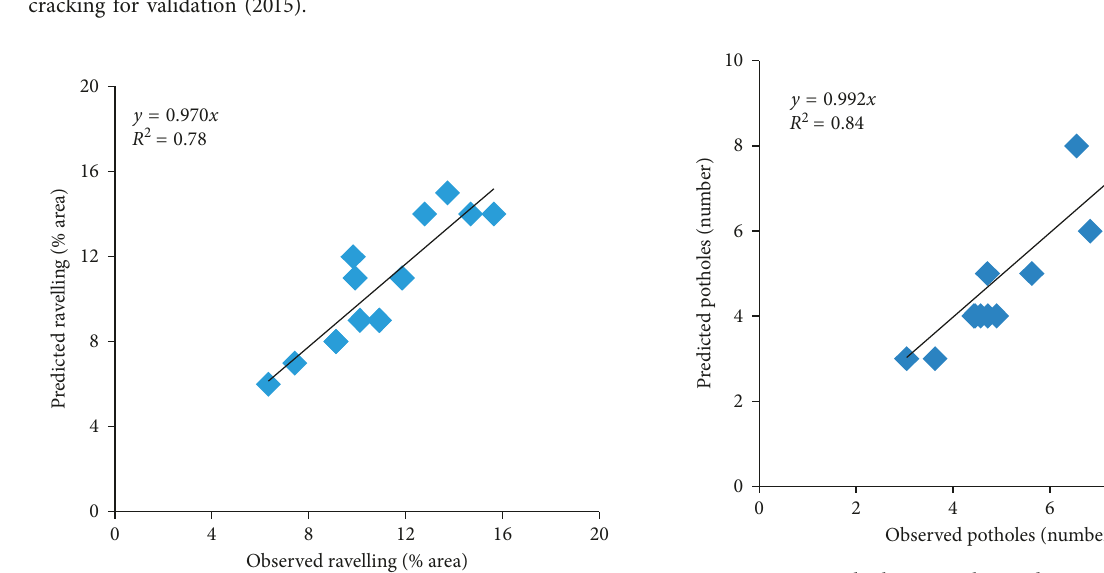
Figure 21: Scatter plot between observed versus predicted ravelling for validation (2014).